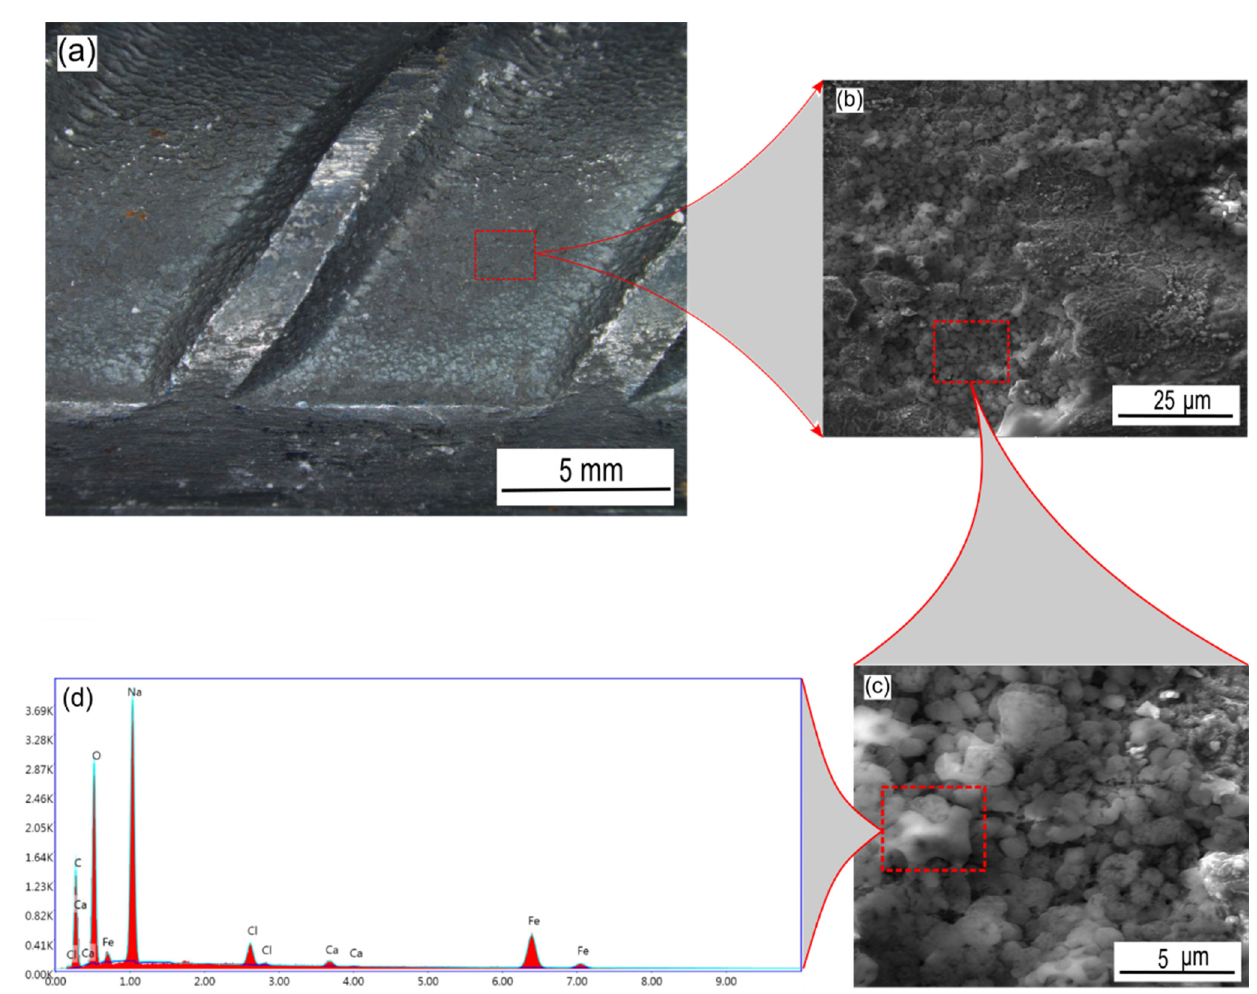
Figure 13. Optical and SEM micrograph of the 0.6 M inhibited carbon steel rebar in 0.6 M Cl − SCPS at 25 °C. ( a ) Surface of the rebar at ×10, ( b ) surface of the rebar at ×2200, ( c ) surface of the rebar at ×8850, and ( d ) EDX elemental spectrum of the complex formation on the surface of the rebar.